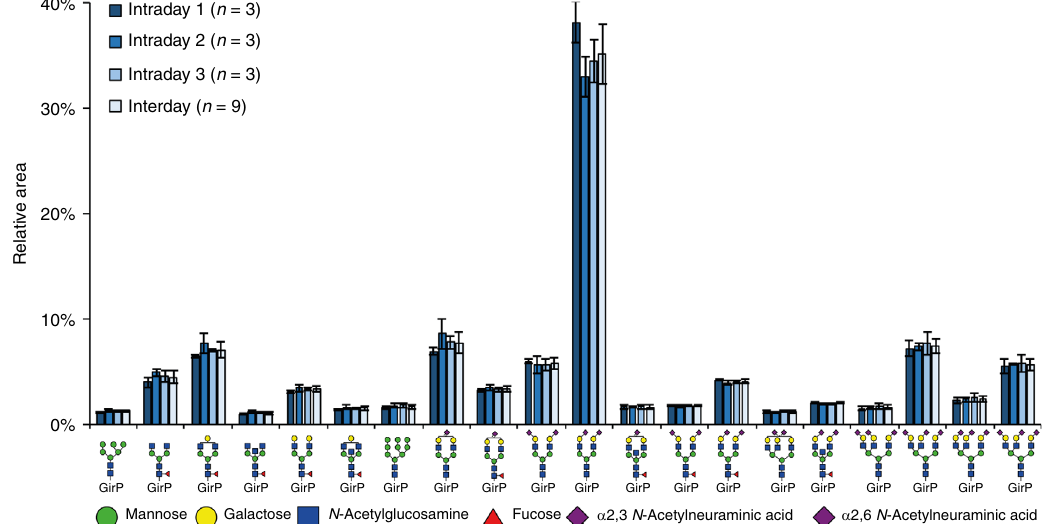
Fig. 4 Inter- and intraday repeatability of the TPNG analysis by CE-ESI-MS. The released N -glycans were analysed after sialic acid derivatization and reducing end labelling with GirP. The relative abundances of the 20 most abundant glycoforms are displayed (for a complete overview, see Supplementary Fig. 7), showing a median RSD of 6.8% within technical replicates form the same day and a median RSD of 9.4% over 3 days. To enable automated peak integration, the electropherograms were aligned prior to data extraction 32 . The relative glycan pro fi les and their variation were similar before and after alignment (Supplementary Figs. 10 and 11). Blue square: N -acetylglucosamine, green circle: mannose, yellow circle: galactose, red triangle: fucose, right pointing pink diamond: α 2,6-linked N -acetylneuraminic acid, left pointing pink diamond: α 2,3-linked N -acetylneuraminic acid, GirP: Girard ’ s reagent P label. Error bars represent the standard deviation (intraday n = 3, interday n = 9, independent technical experiments). Source data are provided as a Source Data fi